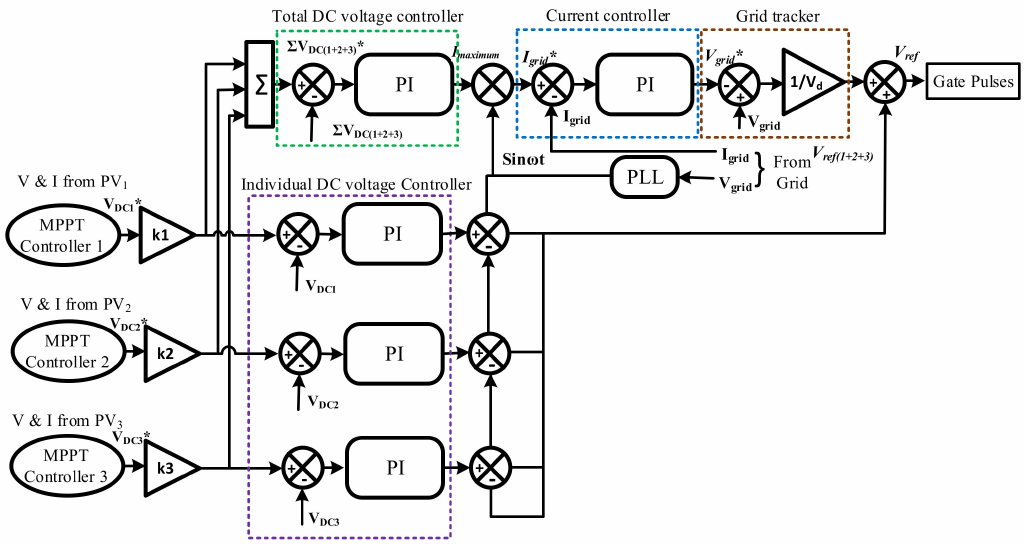
Figure 13. Grid-connected controller for proposed 15-level inverter [23]. ‘*’ refrers to the refer- ence/base values in the figure.